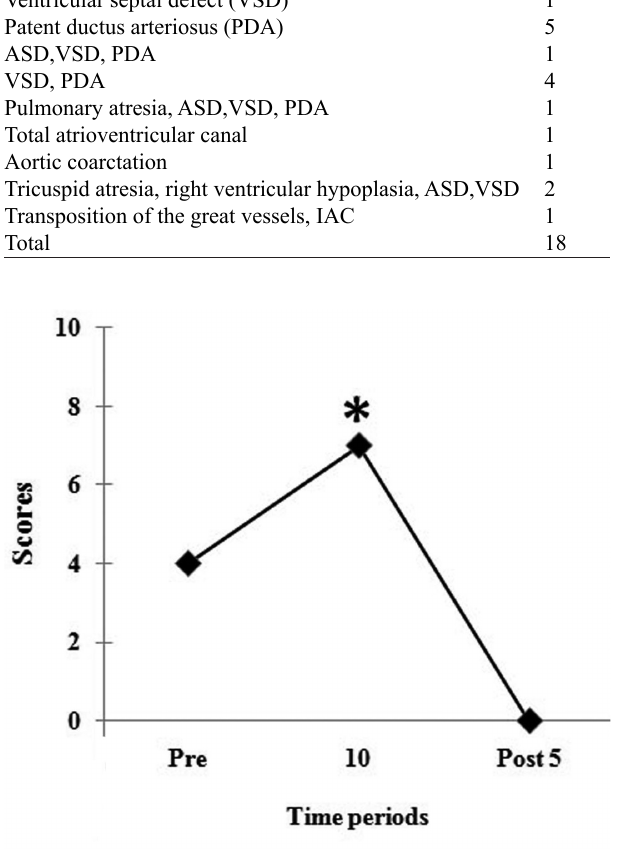
Fig. 1 – Pain during physiotherapy assessed by FLACC scale in 18 children after cardiac surgery. Data represent the median.